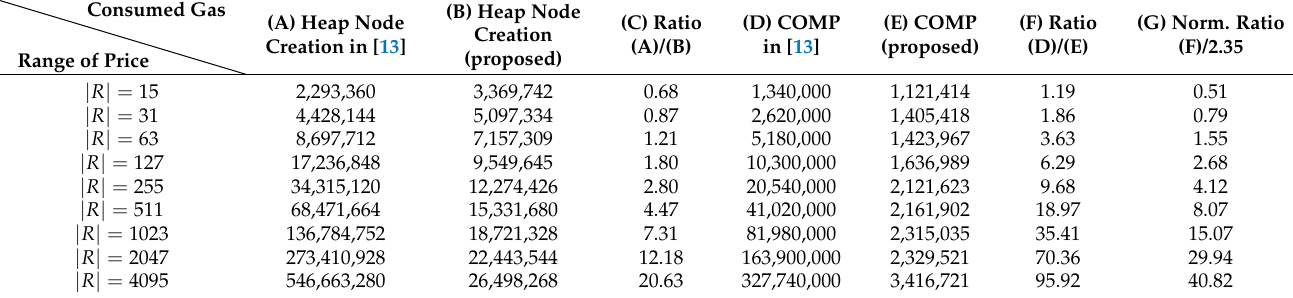
Table 4. Gas cost comparison for the heap node creation and the COMP